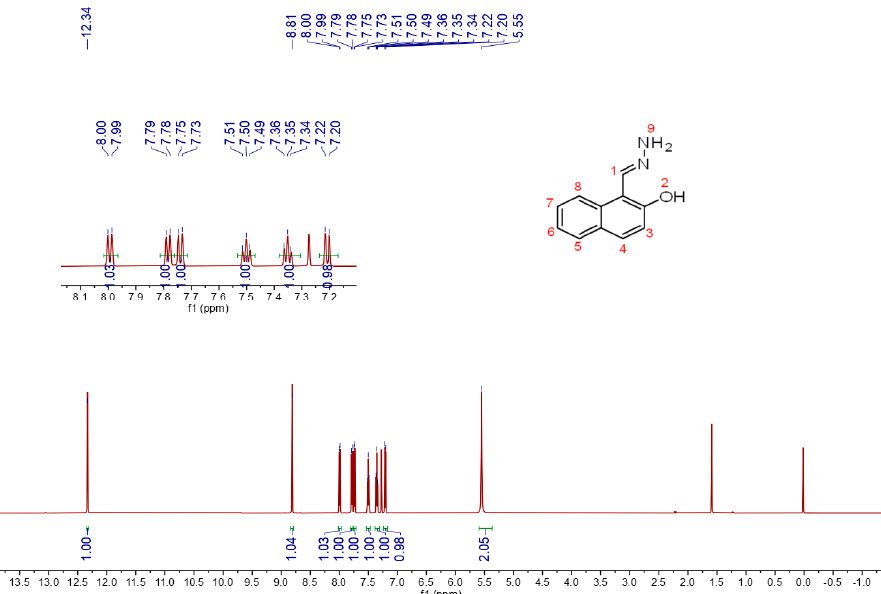
Figure 2. 1 H NMR spectra of the fluorescent probe F6.